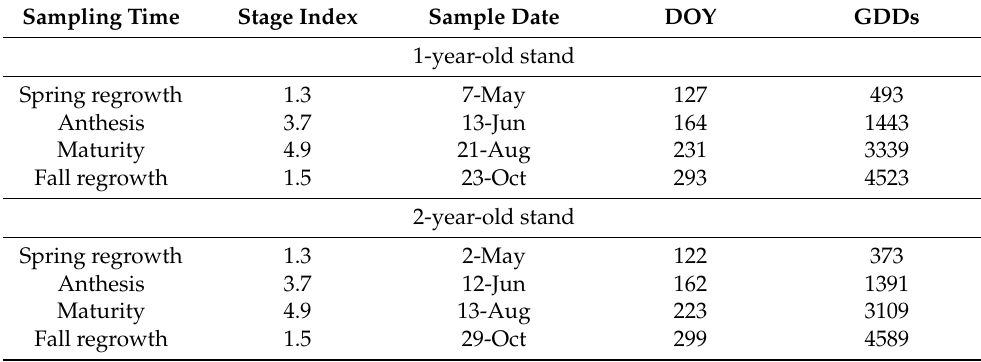
Table 1. Stage index, sampling date, day of year (DOY), and growing degree days (GDDs) accumu- lated to sampling date for four sampling times in 1-year-old and 2-year-old intermediate wheatgrass. Sampling Time Stage Index Sample Date DOY GDDs 1-year-old stand Spring regrowth 1.3 7-May 127 493 Anthesis 3.7 13-Jun 164 1443